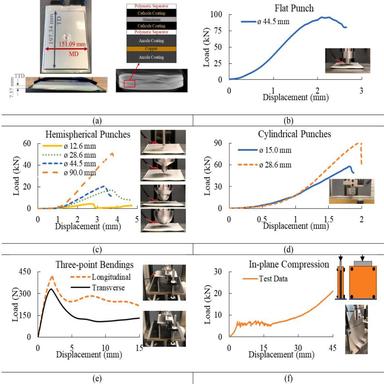
Pouch cell used for the experiments (a) Average dimensions of the pouch cell and the direction conventions. (b) Test setup and load-displacement data under flat punch compression (c) Hemispherical punches and (d) Cylindrical punches (). (e) Longitudinal and transverse three-point bendings performed in-house. (f) In-plane compression test).